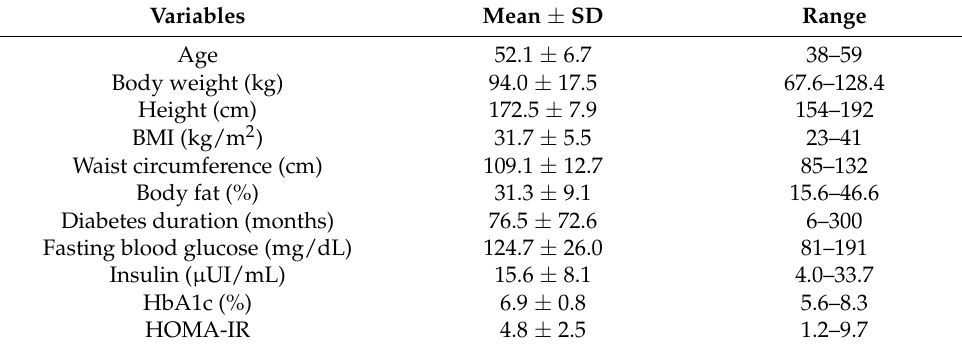
Table 1. Baseline characteristics of study participants ( n = 19).